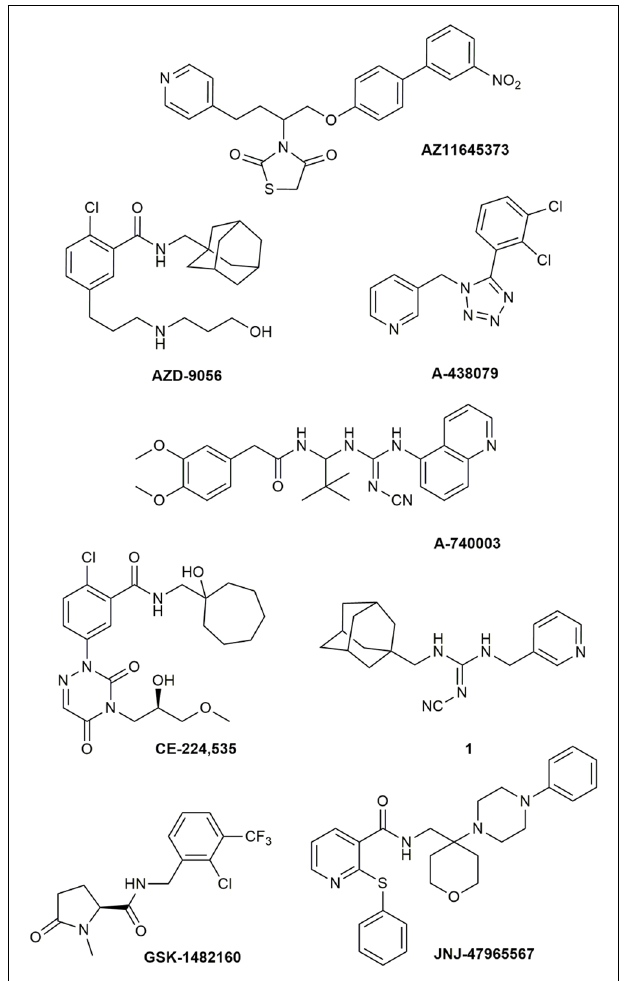
FIGURE 1 | P2X7R antagonists lacking adequate pharmacokinetic properties for the treatment of CNS disorders.